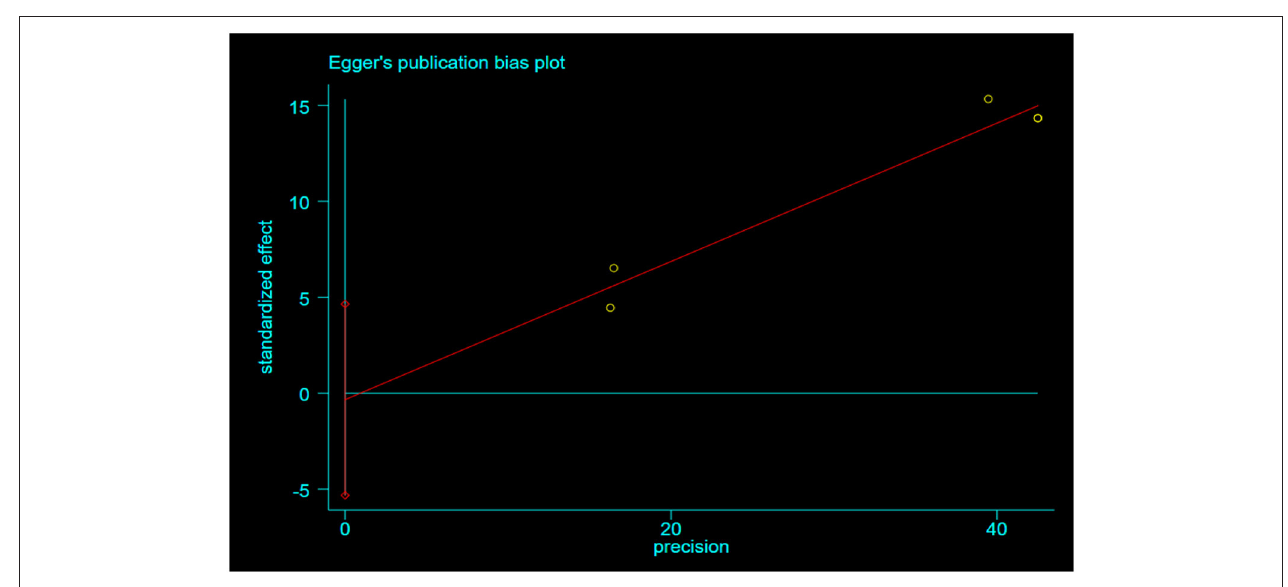
FIGURE 4 | Egger’s publication bias plot for the association between IAD and smoking.